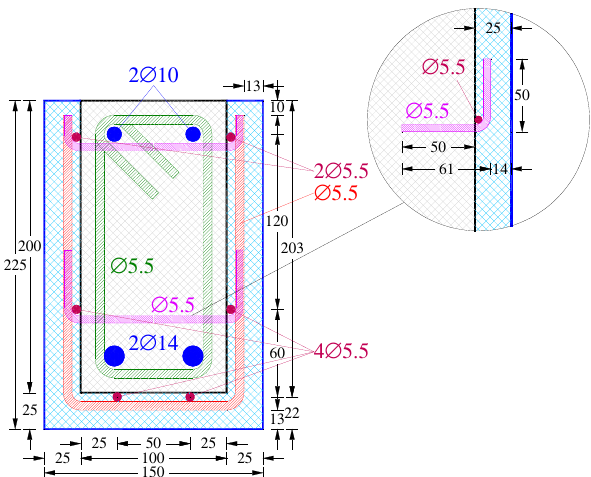
Figure 5. Cross-sectional dimensions and detailed reinforcement layout of the jacketed beams (dimensions in mm).